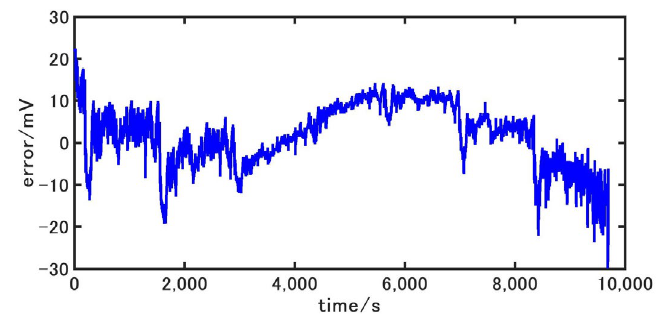
Figure 12. Errors of Terminal Voltage under FUDS Driving Condition.